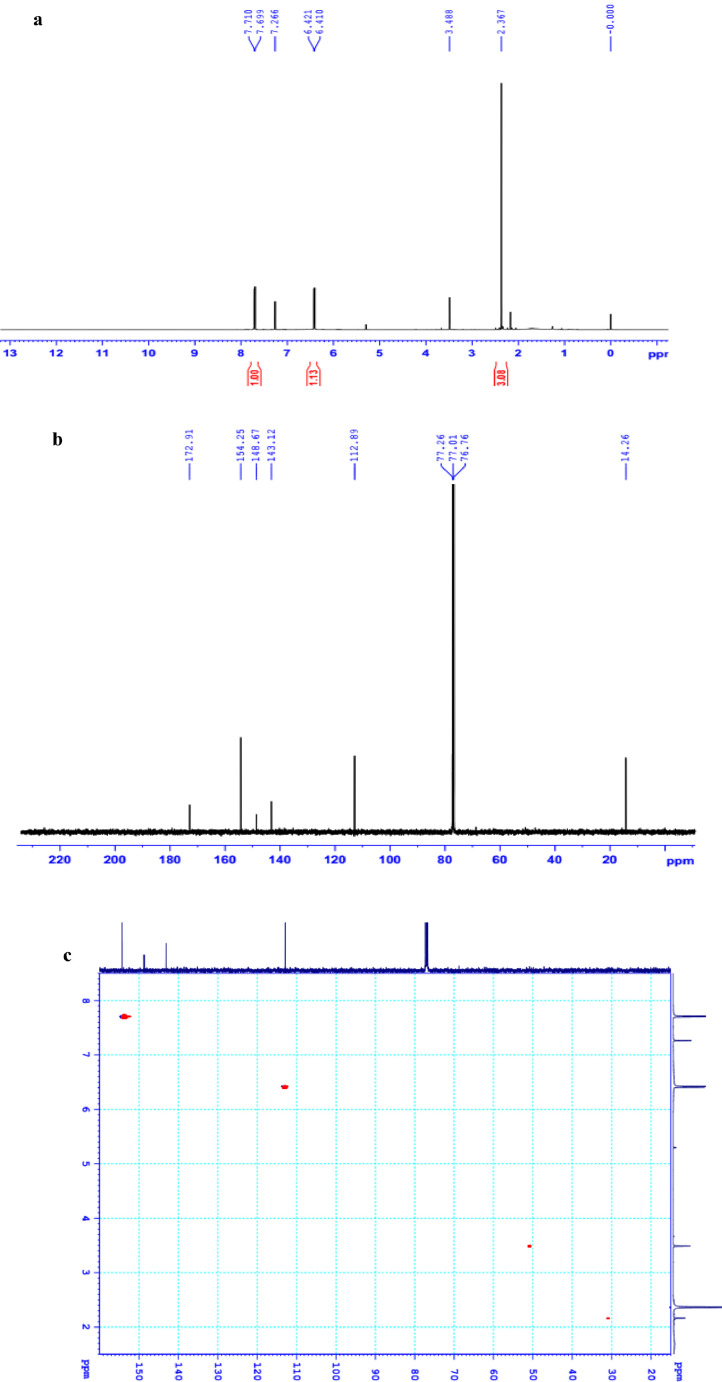
a. 1H NMR (500 MHz, CDCl3) of 1, b. 13C NMR (125 MHz, CDCl3) of 1, c. HSQC of 1, d. HMBC of 1, e. (+) APCI-MS of 1.